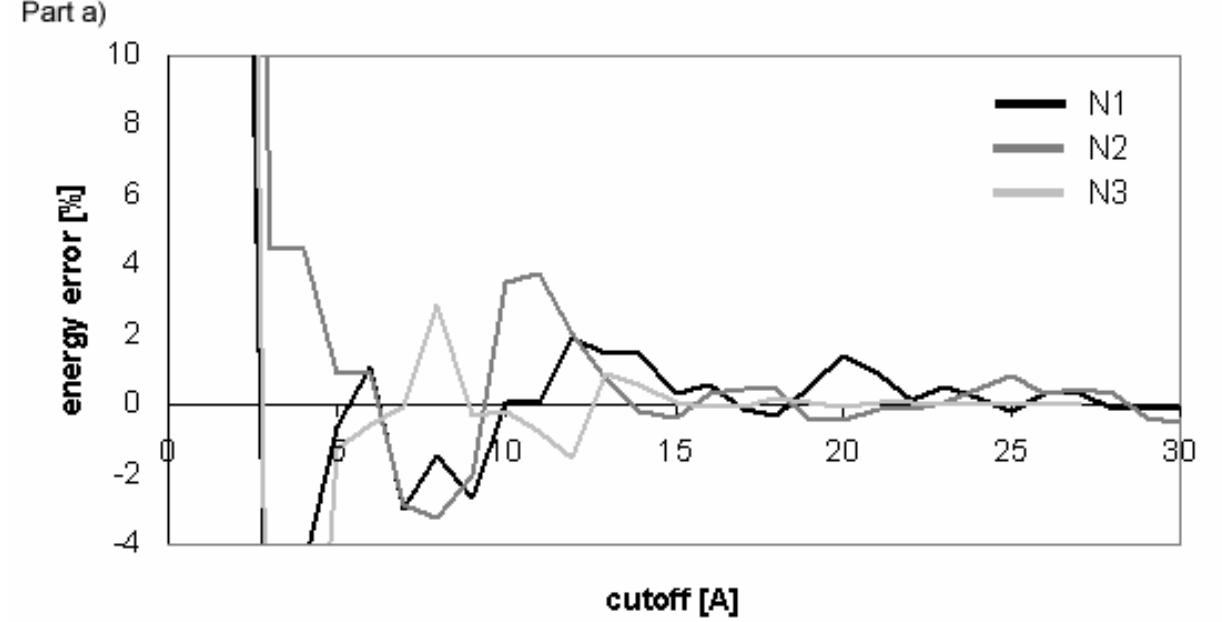
Figure 10. Dependency of energy error on cutoff for conformers of nucleotide-sugar. Energy error is